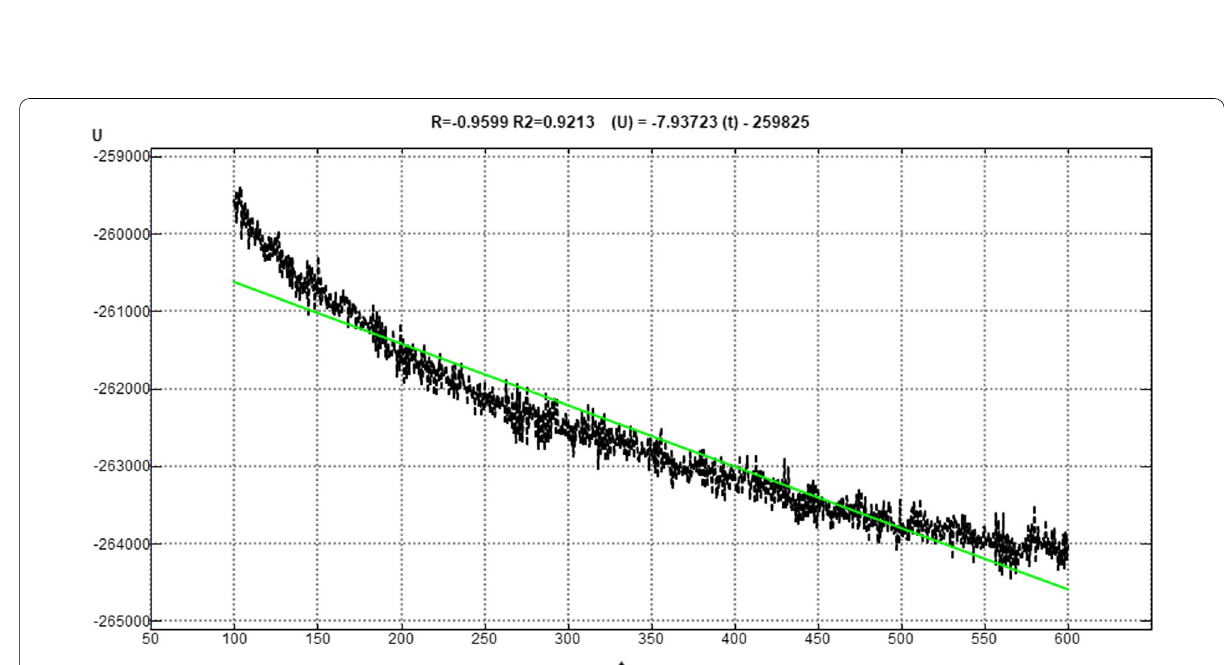
Fig. 14 Plot of Internal Energy ( U ) versus time ( t ) for molecular dynamics study of inhibitor with Index number